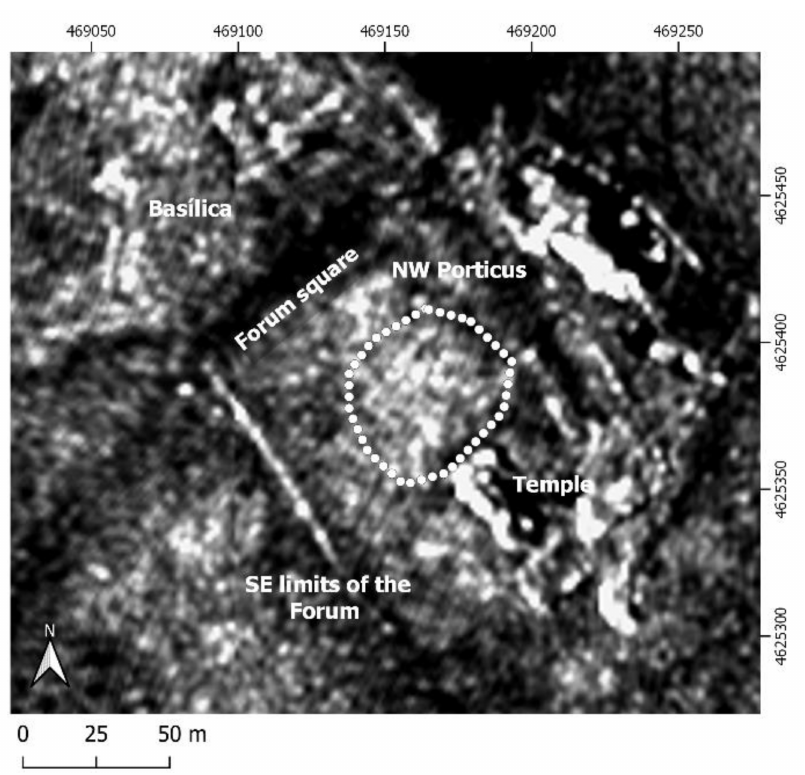
Figure 9. Image resulting from the multi-temporal application of the co-register function with five SAR-X images of PAZ.